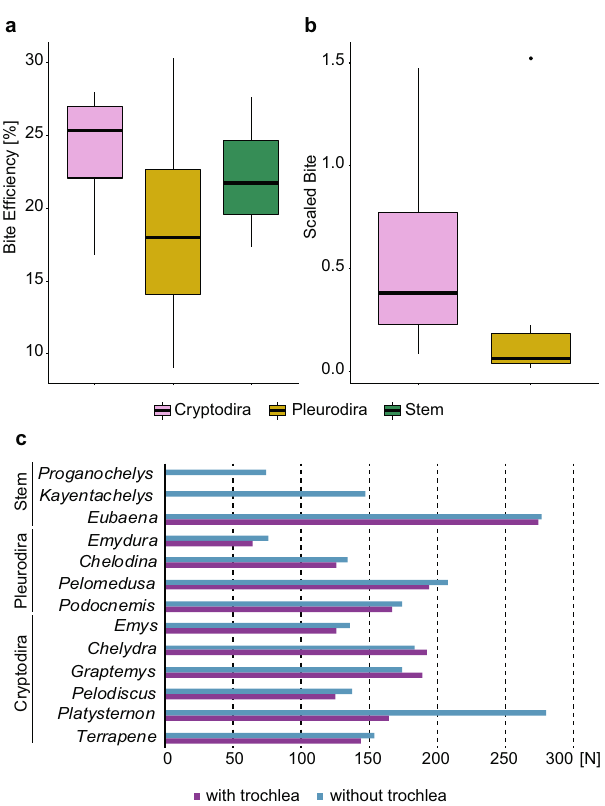
Figure 4. Bite force and efficiency in turtles. ( a–b ), Boxplots of bite efficiency based on ( a ), FEA estimates and ( b ), in vivo measurements (scaled bite force calculated by dividing measured bite force 33 by carapace size). ( c ), Bite force estimates based on FEA for sampled